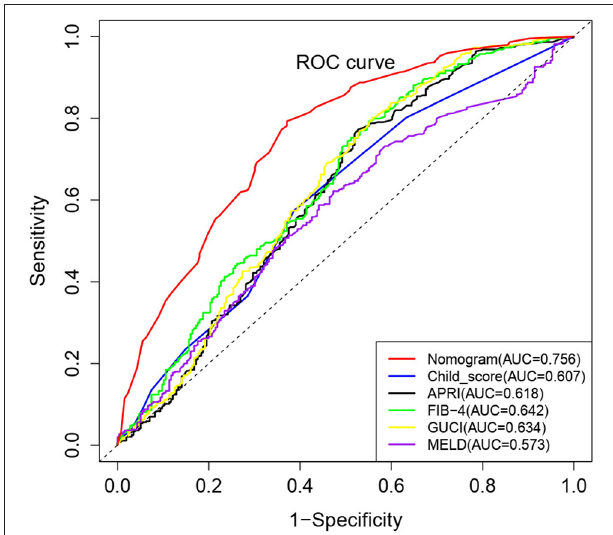
FIGURE 4 | Comparison of ROC curves for different non-invasive parameters using the complete cohort. The nomogram model has the highest diagnostic accuracy with an AUC value